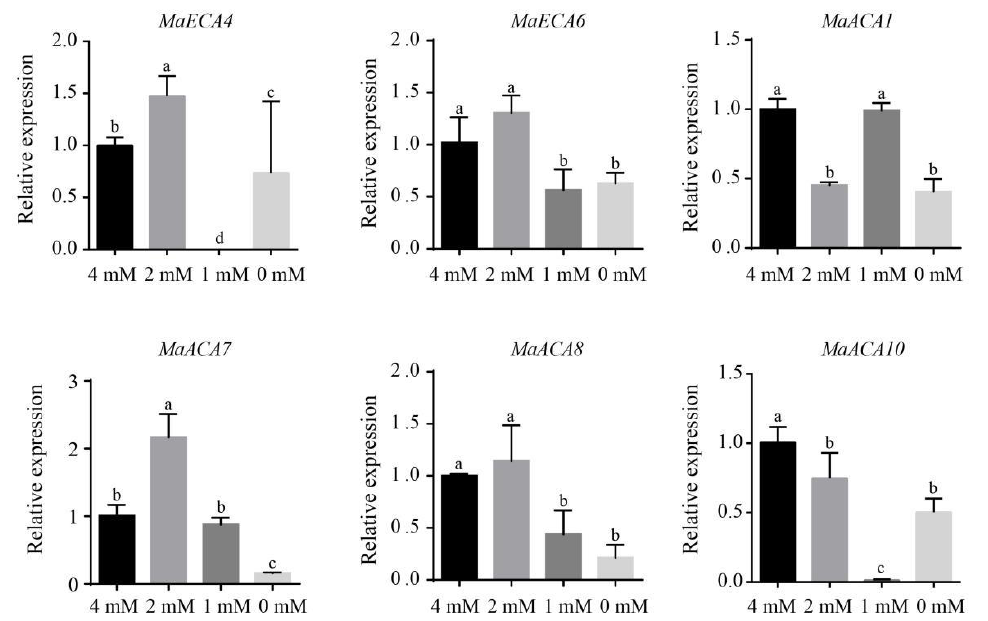
Figure 8. Quantitative real time PCR results of Ca 2+ -ATPase genes in banana roots under different concentrations of Ca 2+ treatments. All data are displayed as mean ± standard deviation (SD) of three replicates. Different lowercase letters above the columns represent significant difference at p < 0.05.